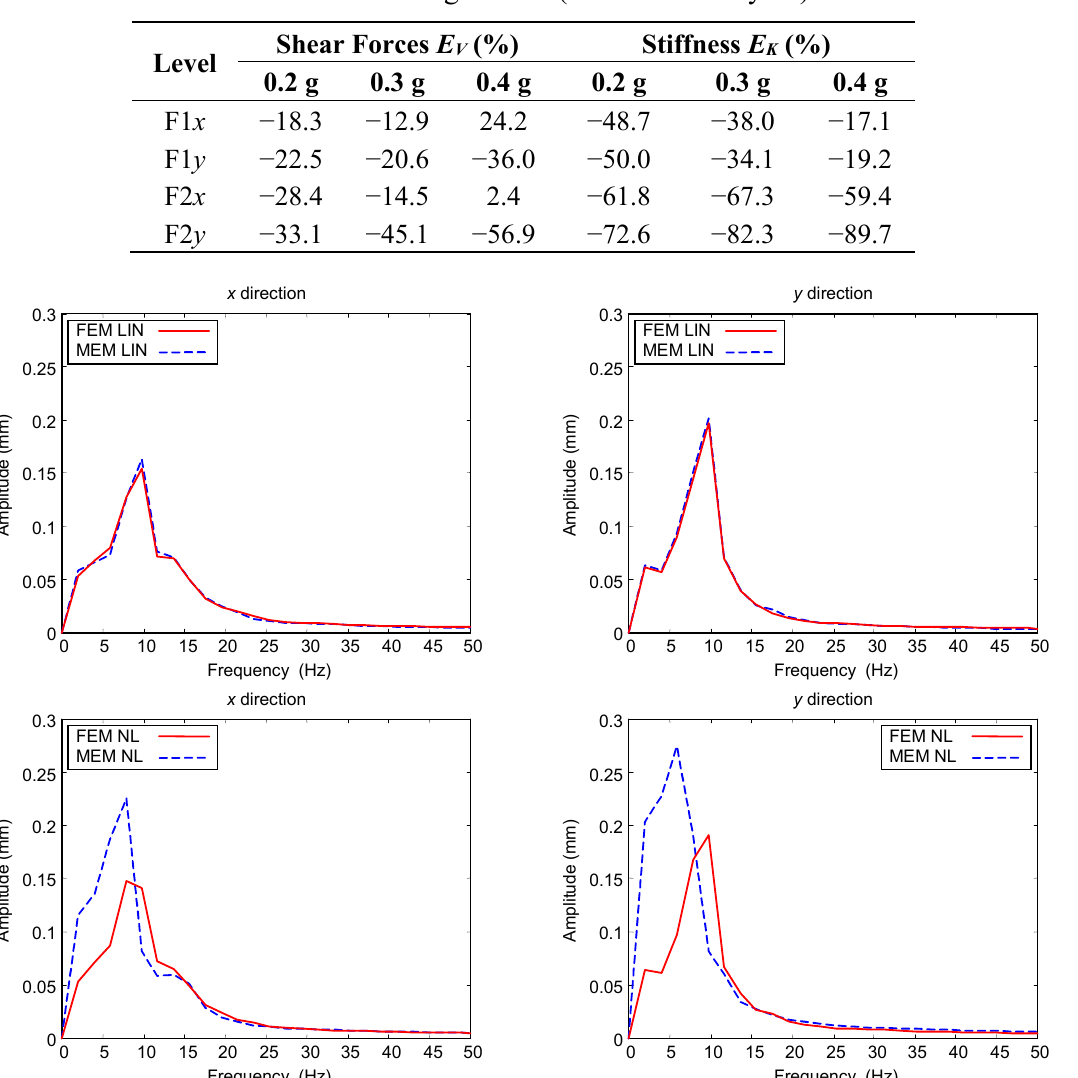
Table 7. Percentage errors (non-linear analyses).